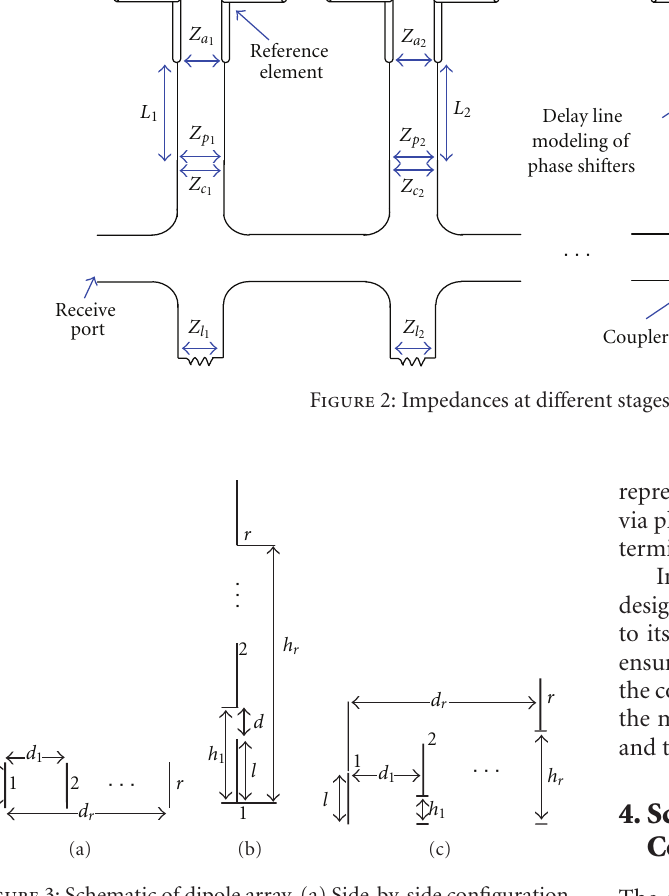
Figure 3: Schematic of dipole array. (a) Side-by-side configuration, (b) collinear configuration, and (c) parallel-in-echelon configura-